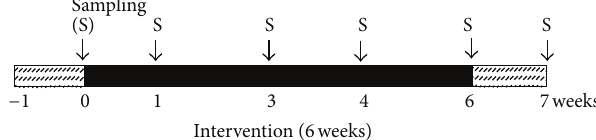
Figure 1: The experiment